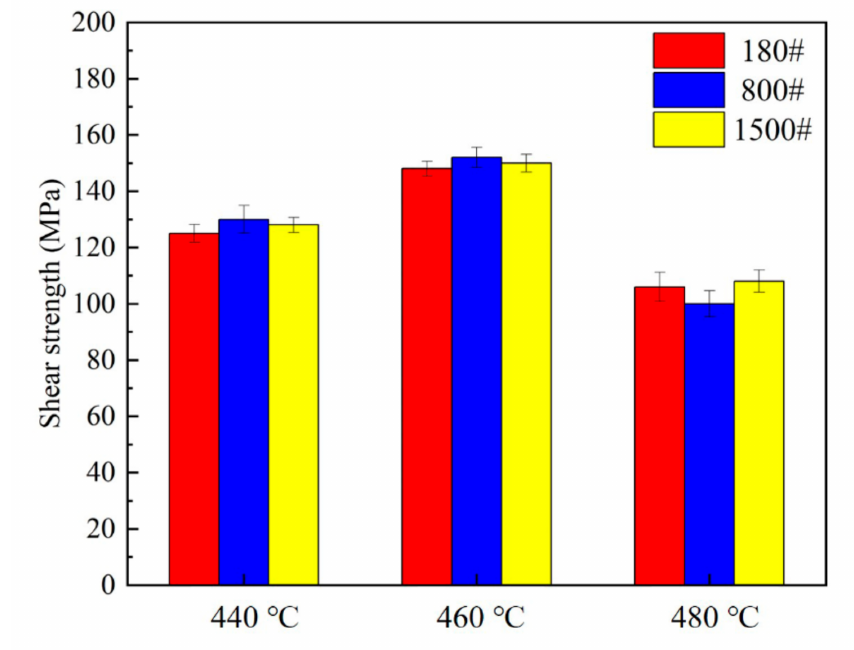
Figure 11. Shear strength of joints under different diffusion bonding conditions.